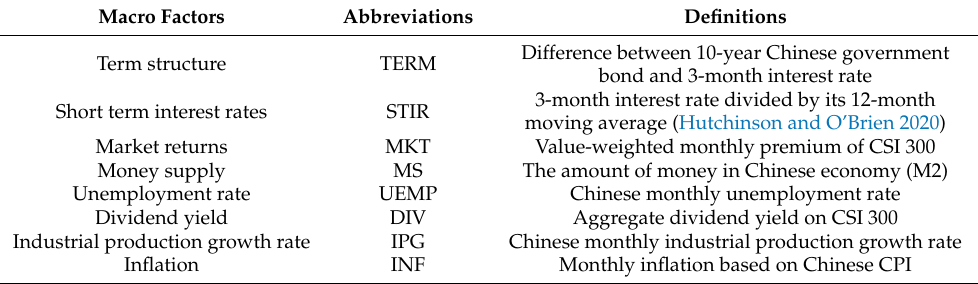
Table 1. Definitions and explanations of macroeconomic control factors.